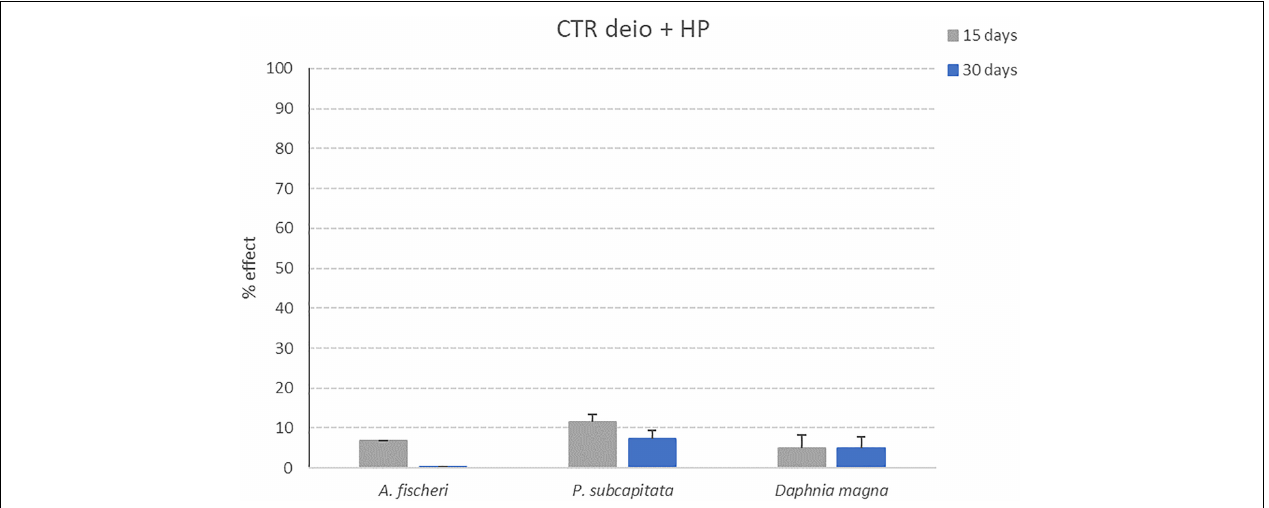
FIGURE 10 | Effect percentages obtained for CTR deio + HP sample (deionized water + Hydrogen Peroxide without microplastics after 15 and 30 days of treatment with photocatalytic reactor) after exposure to the three model organisms ( A. fischeri ; P. subcapitata ; D. magna ). Bars indicate effect percentages recorded for the observed end-points (bioluminescence alteration; algal growth alteration; immobilization) for CTR deio + HP sample collected after 15 (grey bars) and 30 days (blue bars) of treatment with the photocatalytic reactor (M ± ES; n = 3/4 for D. magna